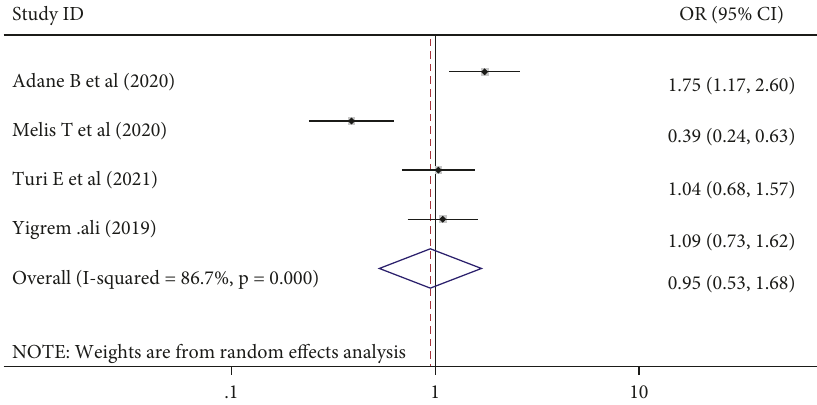
Figure 4: The pooled odds ratio showed the association between perceived stigma and gender difference among people living with HIV/ AIDS and attending ART in Ethiopia,